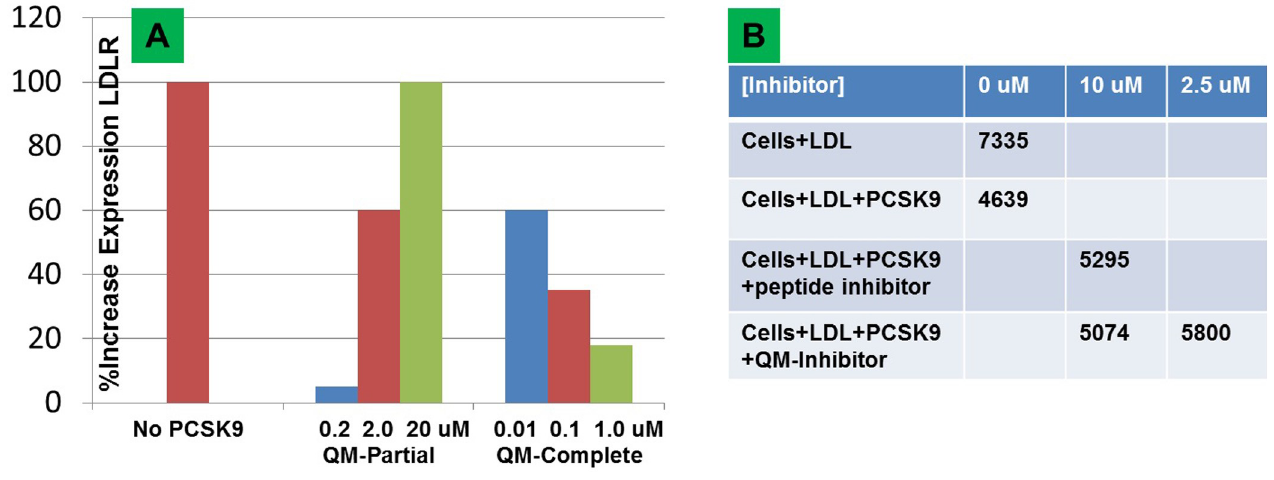
Fig 14. PCSK9 cellular assays. Addition of PCSK9 to HepG cells causes LDLR internalization. LDLR cell surface expression (A) is normalized by assigning 0% and 100% to the experiment with added and no PCSK9 respectively. Using this scale, the compound with the partial QM linker has an EC 50 between 0.2– 2.0 μ M with a typical dose-response curve. The compound with a delocalization linker has an EC 50 < 10 nM with an aberrant inverse dose-response curve (observed with anti-cancer agents, see discussion) due to π - π stacking. We tested the compound with a linker that supports delocalization (B) in fluorescently labeled LDL uptake assays with HepG cells. When the compound blocks PCSK9, more LDL particles are internalized inside the cells and the fluorescence remains after a wash. We used a peptide inhibitor known to block PCSK9 with 1 μ M affinity as a positive control. The fluorescence of the cells after application of labeled LDL is 7335, but reduced to 4639 with application of PCSK9 and partially restored to 5295 when 10 μ M of peptide is added. The complete inhibitor shows inverse dose-response in this assay also, becoming dramatically more potent when lowering the concentration from 10 μ M to 2.5 μ M. Japan Tobacco obtained almost identical results upon repeating the assays several times and so supplied us with the average values. We repeated our experiments six times and obtained very similar results in all cases.